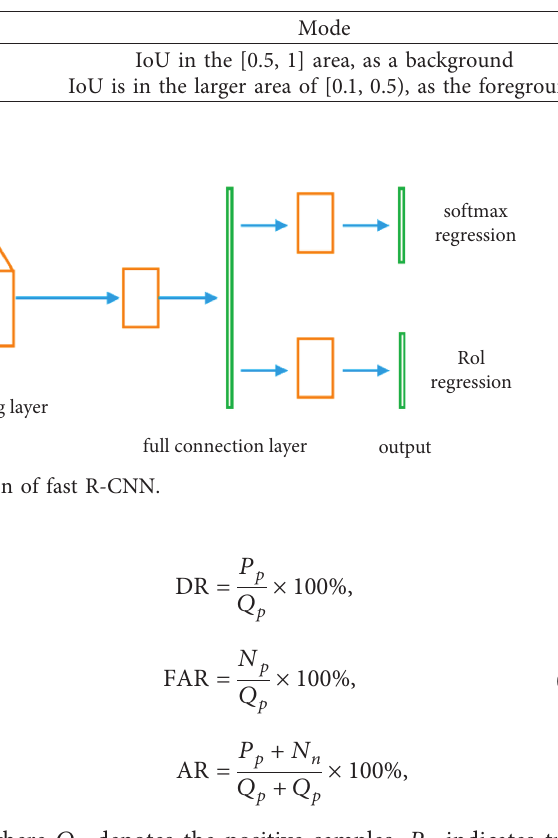
Table 1: RoIs sources.